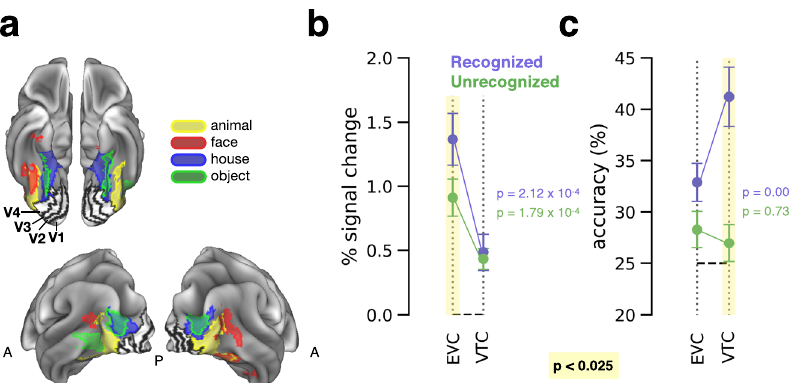
Fig. 5 Object recognition in visual areas. a For visualization purposes, group-level visual ROIs are plotted on a template cortical surface. Ventral temporal cortex (VTC, category-selective) ROIs were obtained from a group-level category localizer GLM analysis. Early visual cortex (EVC, V1 – V4) outlines are taken from the vcAtlas 101 . Top: ventral view; bottom: posterior view. Analyses were performed using subject-level EVC and VTC ROIs derived via individual functional localizers. b GLM-estimated percent signal change in response to object stimuli, averaged across object categories and voxels in individually- de fi ned visual ROIs. ROIs were averaged together within early (EVC) and higher-order (VTC) areas. Error bars indicate s.e.m. across subjects (EVC N = 23, VTC N = 25). c Object category decoding accuracy within individually-de fi ned early visual cortex (EVC) and category-selective ventral temporal cortex (VTC) ROIs. Shaded columns: signi fi cant difference between recognized and unrecognized, p < 0.025, paired t -test. Error bars indicate s.e.m. across subjects ( N = 23; EVC and VTC ROIs were matched for the number of voxels, so this analysis only included the 23 subjects with EVC ROI de fi nition).